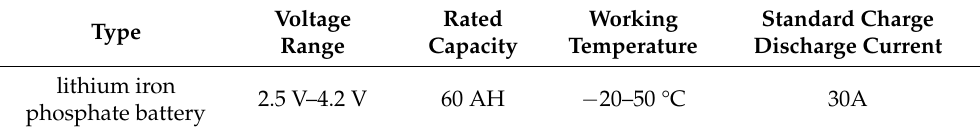
Table 2. Battery parameters.